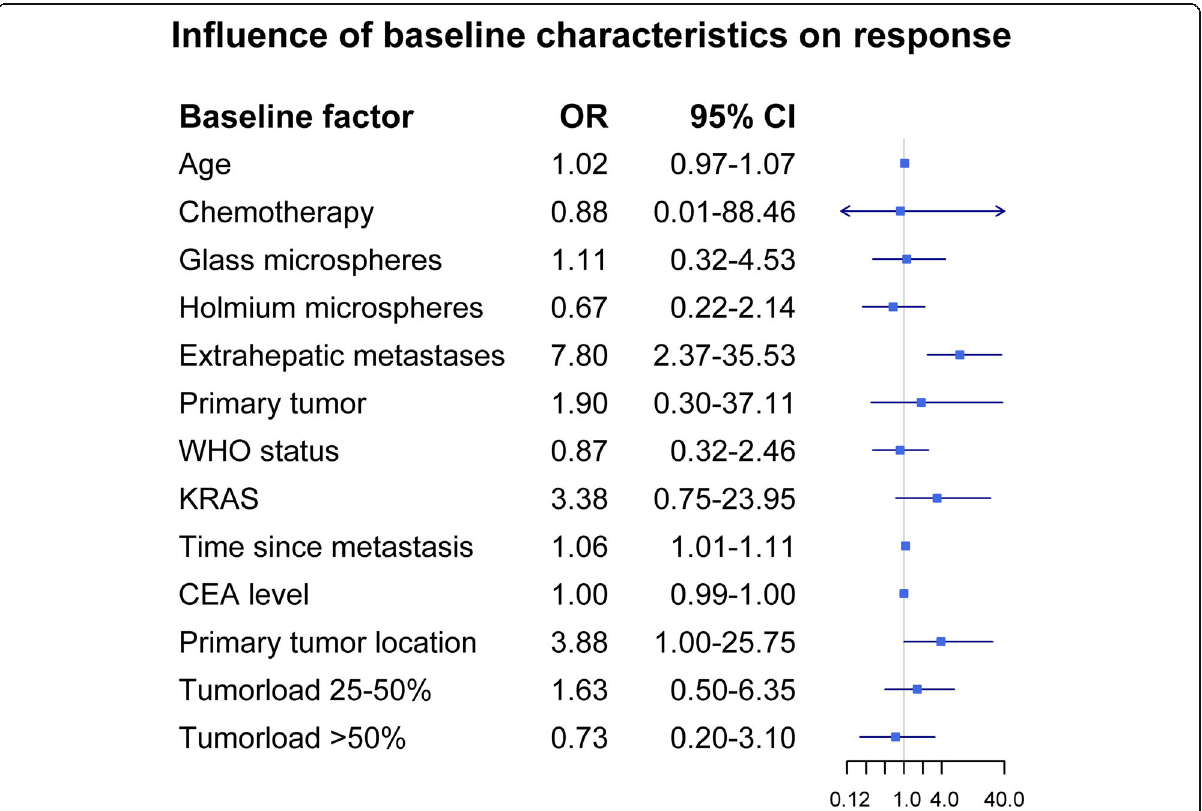
Fig. 3 Forest plot of the influence of baseline characteristics on response (progression versus no progression according to RECIST 1.1), based on univariable